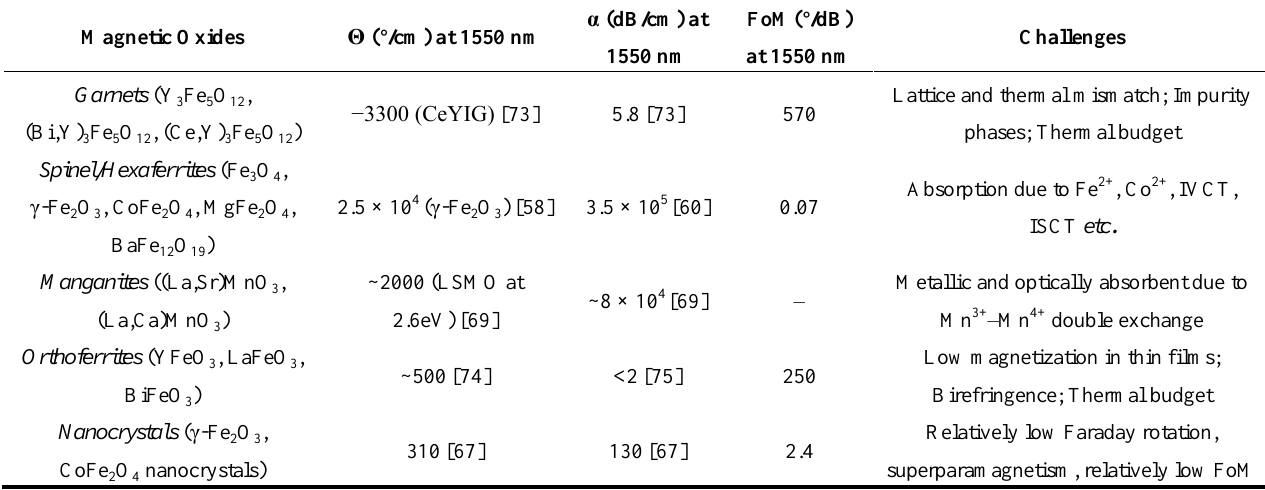
Table 1. Magneto-optical properties of several magnetic oxides and challenges for applications in on-chip nonreciprocal photonic